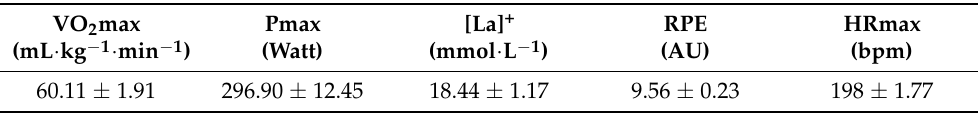
Table 2. The responses of the rowers after the cardiopulmonary exercise test (CPET). Data are the mean ± SE. VO 2 max, maximal oxygen uptake; Pmax, power at VO 2 max; [La] + , blood lactate concentration; RPE, rating of perceived exertion; HRmax, maximal heart